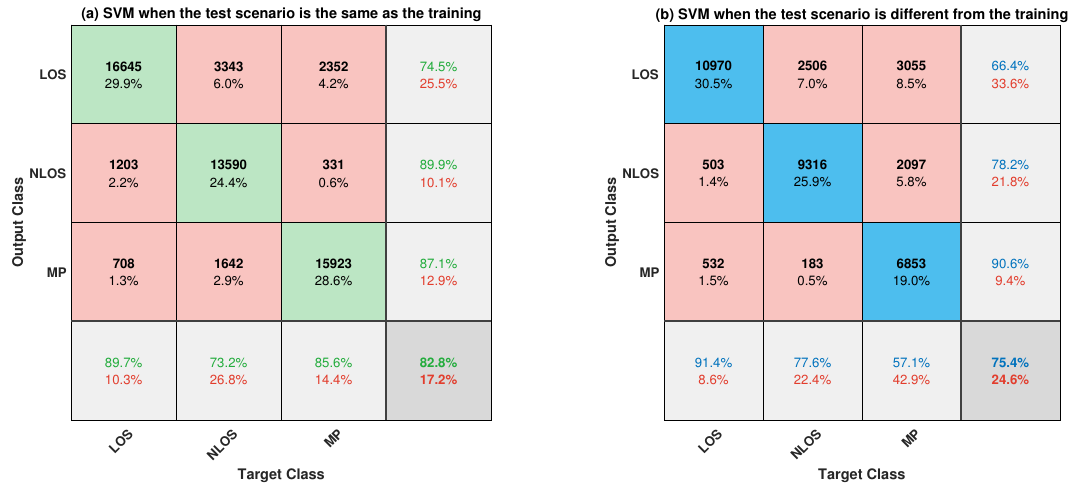
Figure 8. Comparison of the multi-label classification results for SVM using the confusion matrix in two different scenarios: ( a ) the test dataset was obtained from the same environments as in the training state; ( b ) the test dataset was collected in the environments different from the training state. In the evaluation, the radial basis function was used as the kernel for the SVM